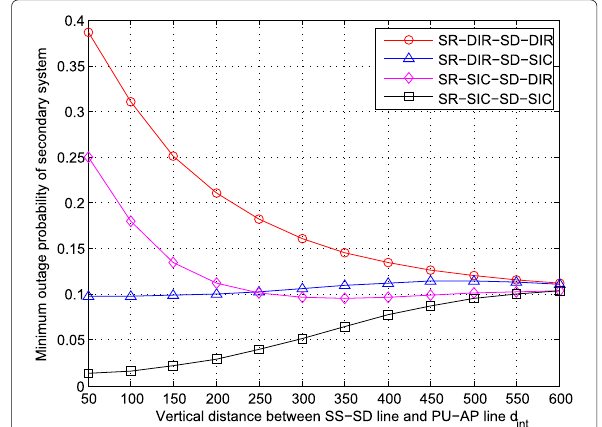
Fig. 11 Minimum outage probability of secondary system vs the distance factor d int